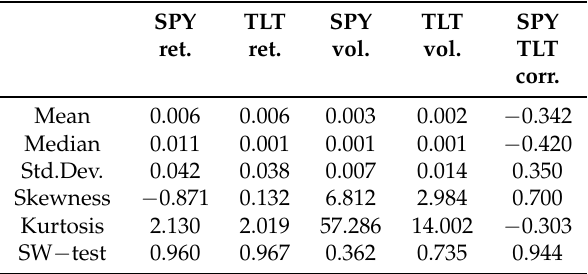
Table 6. Descriptive Statistics for monthly data, sample size is n 2 = 135 months from 08/2002 to 02/2016, SW short for